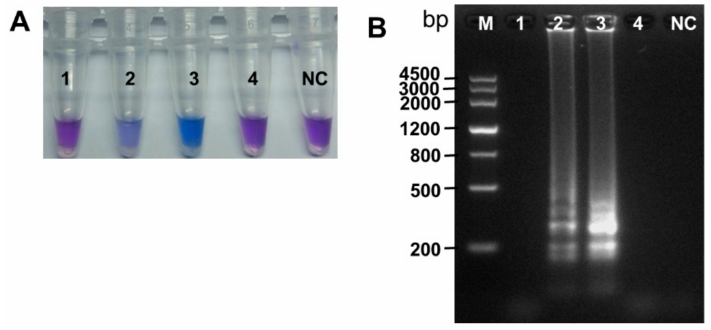
Figure 2. Effects of different reaction temperatures on efficiency and specificity of loop-mediated isothermal amplification (LAMP) amplification. ( A ) Visualization by hydroxynaphthol blue (HNB) in amplification tubes. Sky blue color indicates positive DNA amplification of Marssonina brunnea (Tubes 2 and 3). ( B ) The 2% agarose gel showing products from LAMP reaction. Ladder-like pattern indicates positive reactions (lanes 2 and 3). M, molecular size ladder; tubes and lanes 1–4, LAMP reactions carried out with 100 pg genomic DNA of M. brunnea f. sp. multigermtubi strain XY-3 at different incubation temperatures (60, 62.5, 65.0, 67.5 ◦ C, respectively); NC = negative control (no